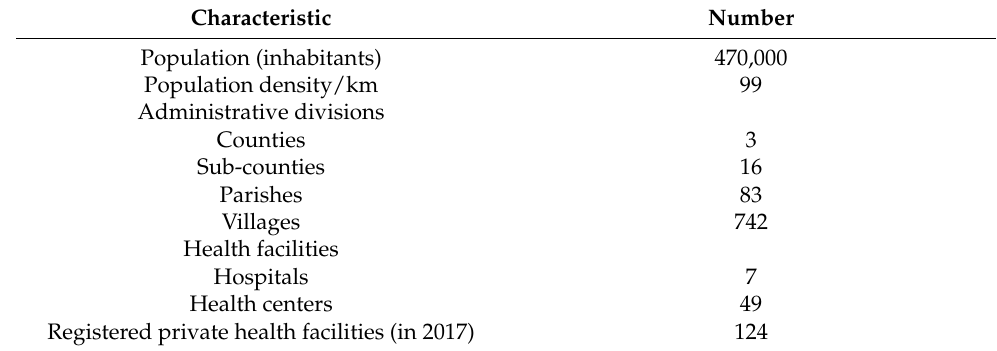
Table 1. Some characteristics of Mbarara